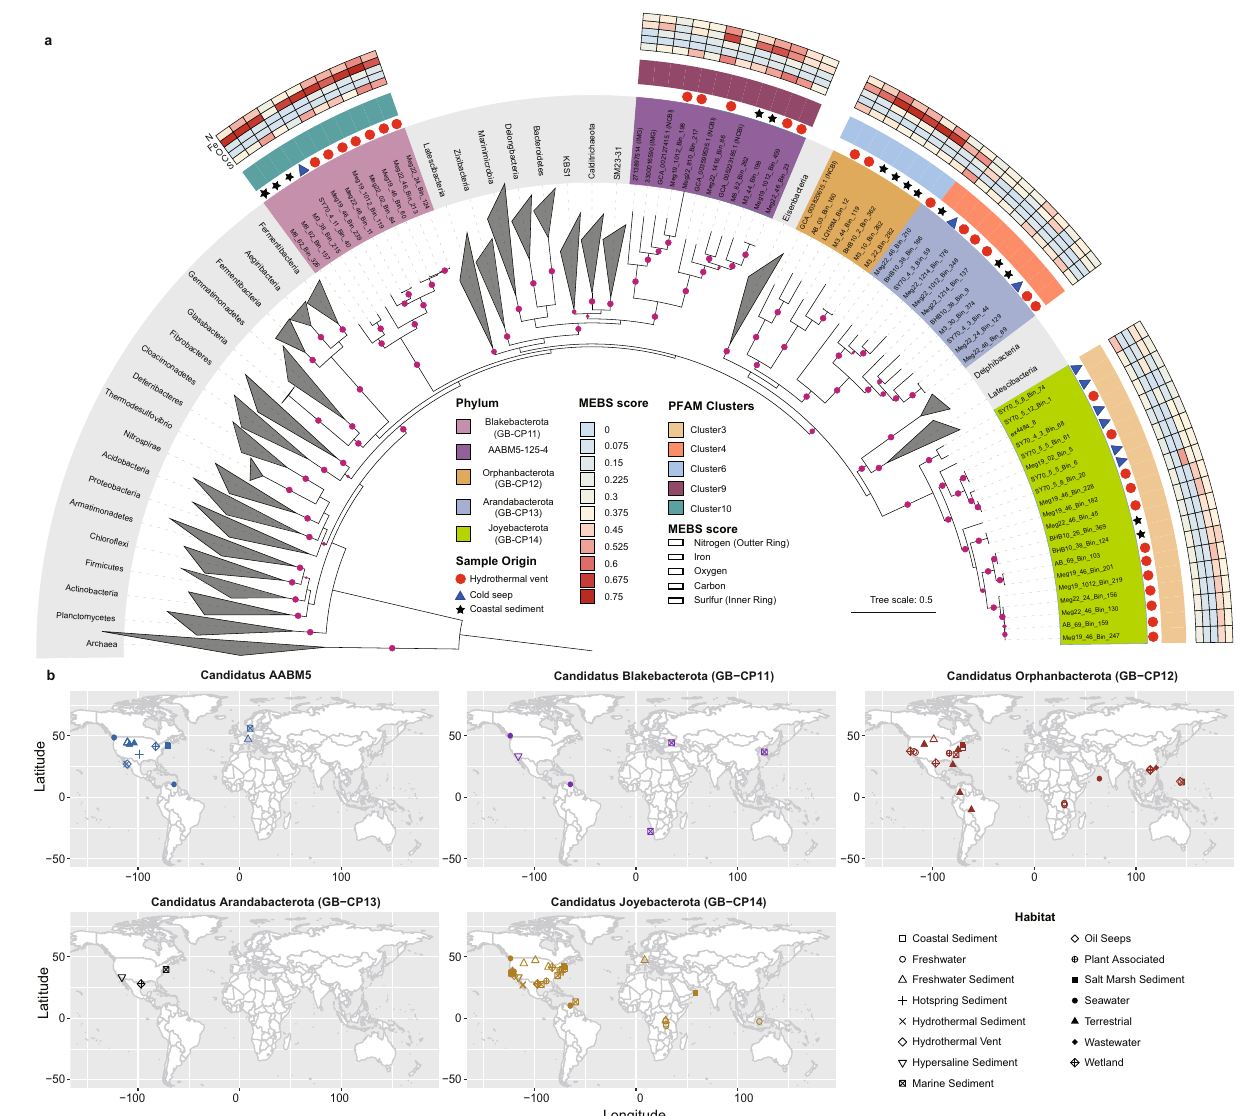
Fig. 1 | Phylogeny of four newly proposed and one understudied phyla and an overview of their metabolic potential and global distribution. a A maximum likelihood phylogenetic tree of 345 genomes including the 55 metagen- ome assembled genomes (MAGs) described in this study. The phylogeny is based on 37 concatenated ribosomal protein encoding genes identi fi ed using PhyloSift. The fi ve lineages are marked in different background colors with symbols indi- catingtheenvironmentalsourceofeachgenome.Themetabolicpotentialofnewly reconstructed genomes is shown in the outer heatmap for nitrogen (N), iron (Fe), oxygen (O), carbon (C), and sulfur (S), determined using Metagenomic Entropy BasedScores(MEBS).Theseentropy-basedscoresindicatethelikelihoodofagiven